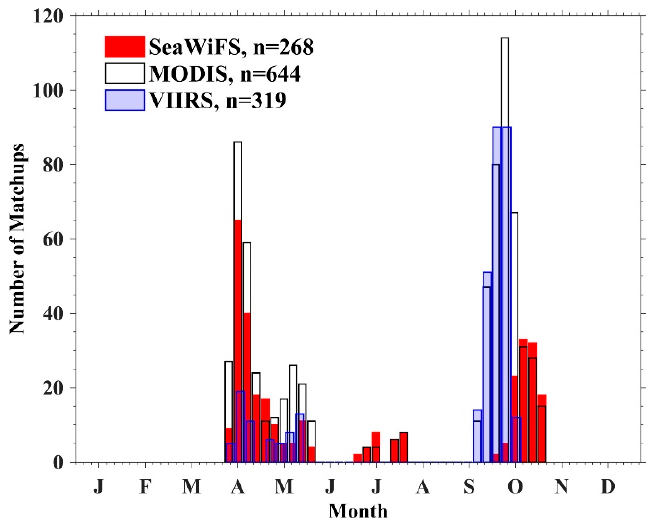
Figure 2. Seasonal distribution of in situ and satellite matchups.